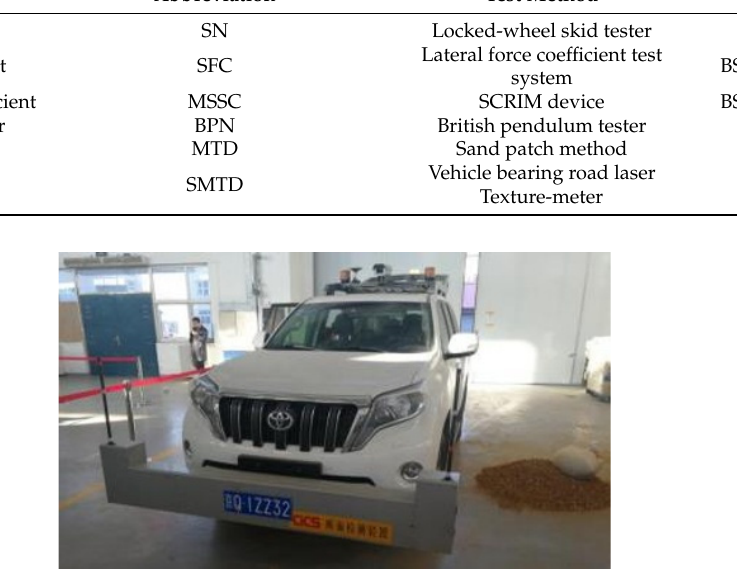
Figure 3. Multifunctional vehicle equipped with a laser texture depth tester. The vehicle-carried laser texture depth meter is an instrument that uses the laser range and distance sensors to automatically and quickly detect the pavement surface texture